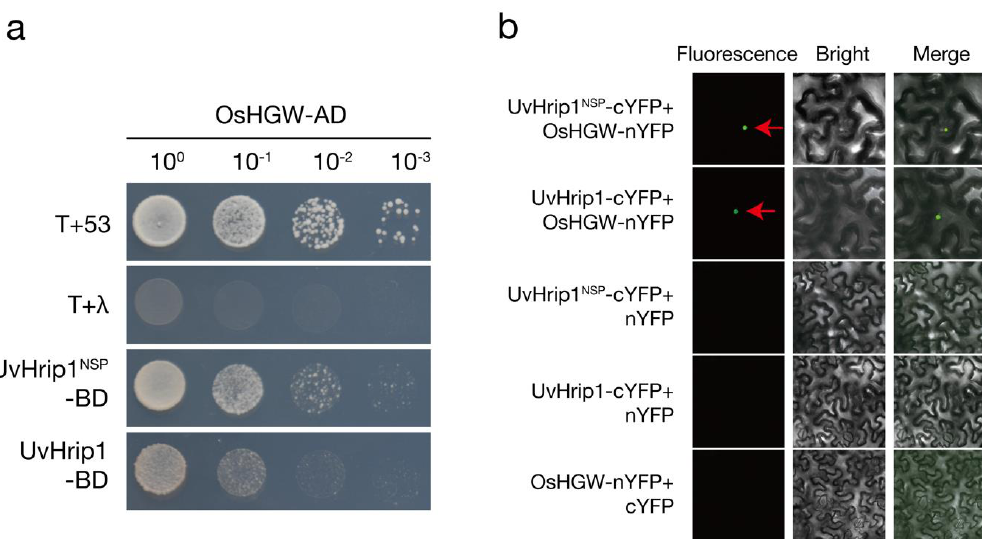
Figure 4. UvHrip1 interacts with OsHGW in vi vo and in vitro . ( a ) Yeast two-hybrid assays revealed the interaction between UvHrip1 and OsHGW. pGADT7- OsHGW was co-transformed with pGBKT- uvhrip1 or pGBKT- uvhrip1 nsp in yeast strain Gold. Quadruple dropout medium (QDO) is used for interaction screening. The pGADT7-T plasmid was transformed to yeast with pGBKT7-53 or pGBKT7-Lam for positive and negative controls, respectively. T, pGADT7-T; 53, pGBKT7-53; λ , pGBKT7-Lam. ( b ) The in planta interaction between UvHrip1 and OsHGW was indicated by bimolecular fluorescence complementation (BiFC). Green fluorescence of N. benthamiana cells was observed by confocal microscopy at 3 days post agroinfiltration. The red arrows indicated nuclei.